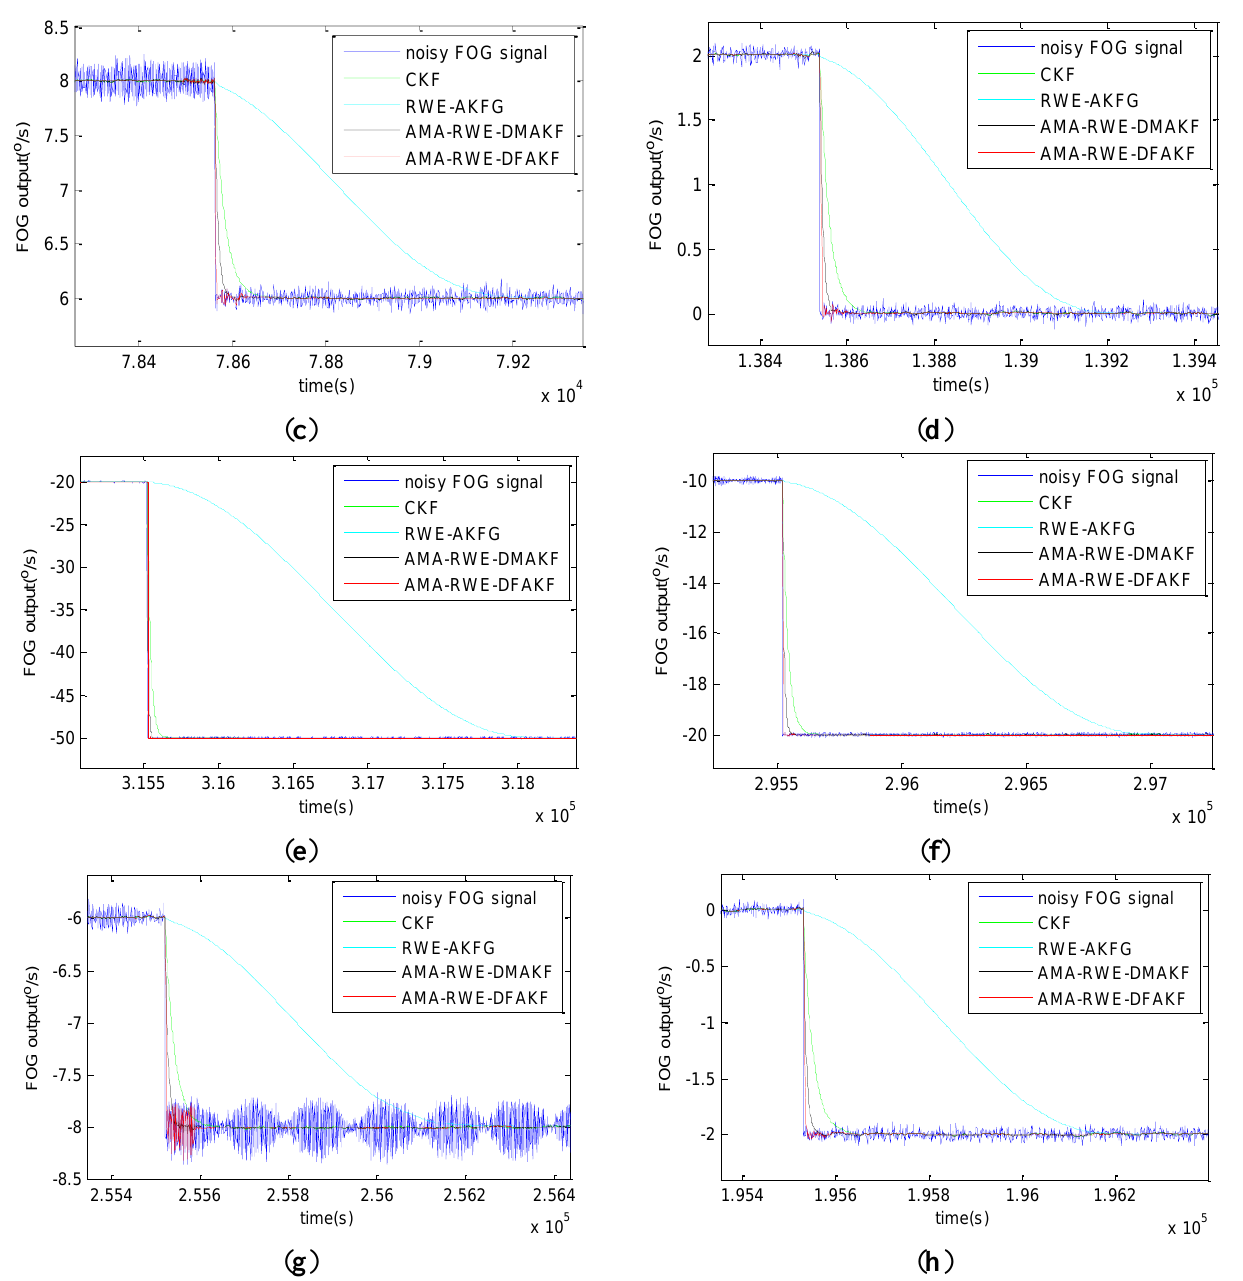
Figure 8. Comparison of denoising results for FOG dynamic signal at different rotations. ( a ) Rotation rate from 50 to 20°/s; ( b ) Rotation rate from 20 to 10°/s; ( c ) Rotation rate from 8 to 6°/s; ( d ) Rotation rate from 2 to 0°/s; ( e ) Rotation rate from −20 to −50°/s; ( f ) Rotation rate from −10 to −20°/s; ( g ) Rotation rate from −6 to −8°/s; ( h ) Rotation rate from 0 to